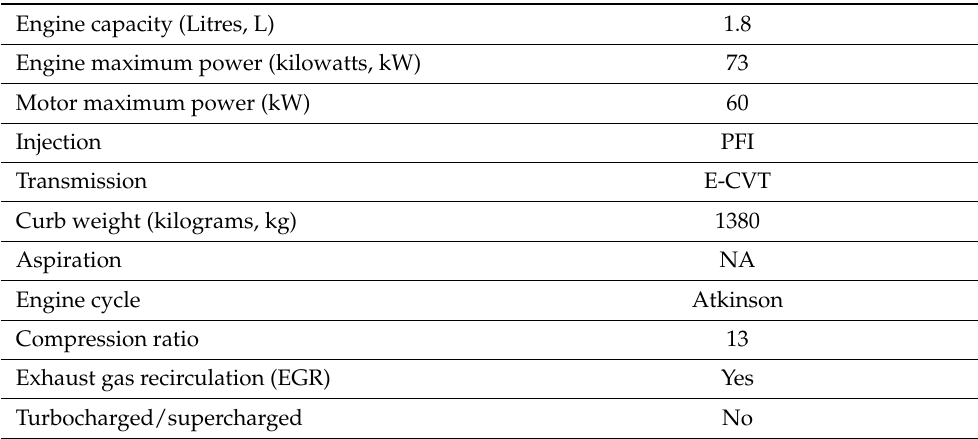
Table 1. Properties of the HEV research vehicle. Engine capacity (Litres, L) 1.8 Engine maximum power (kilowatts,